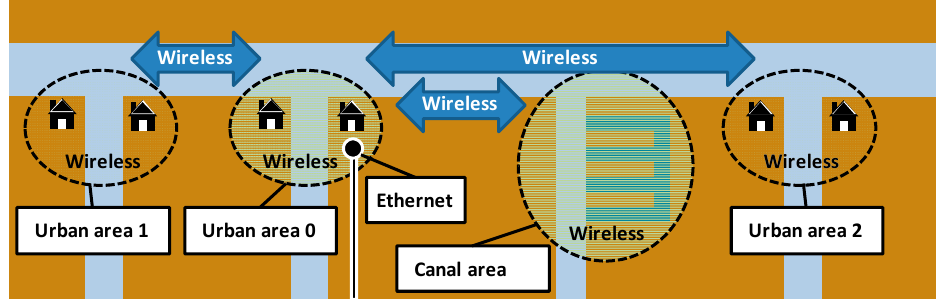
Figure 1. Deployment of node areas.